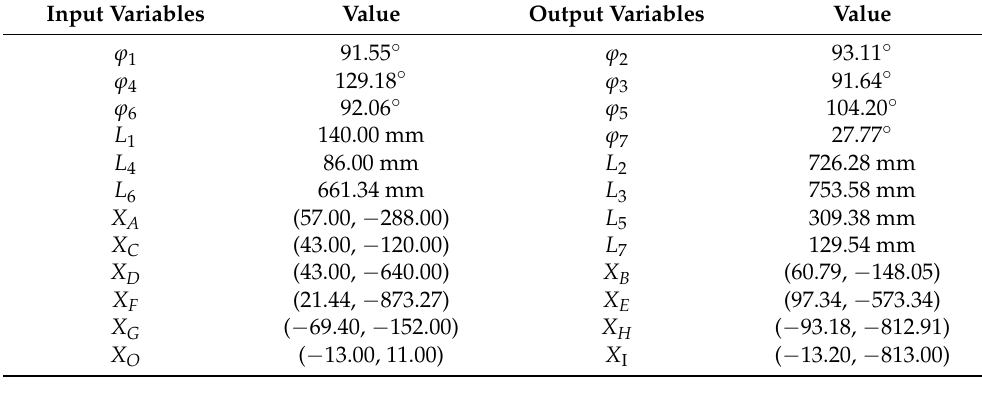
Table 3. Values of the input and output design variables of truss-link